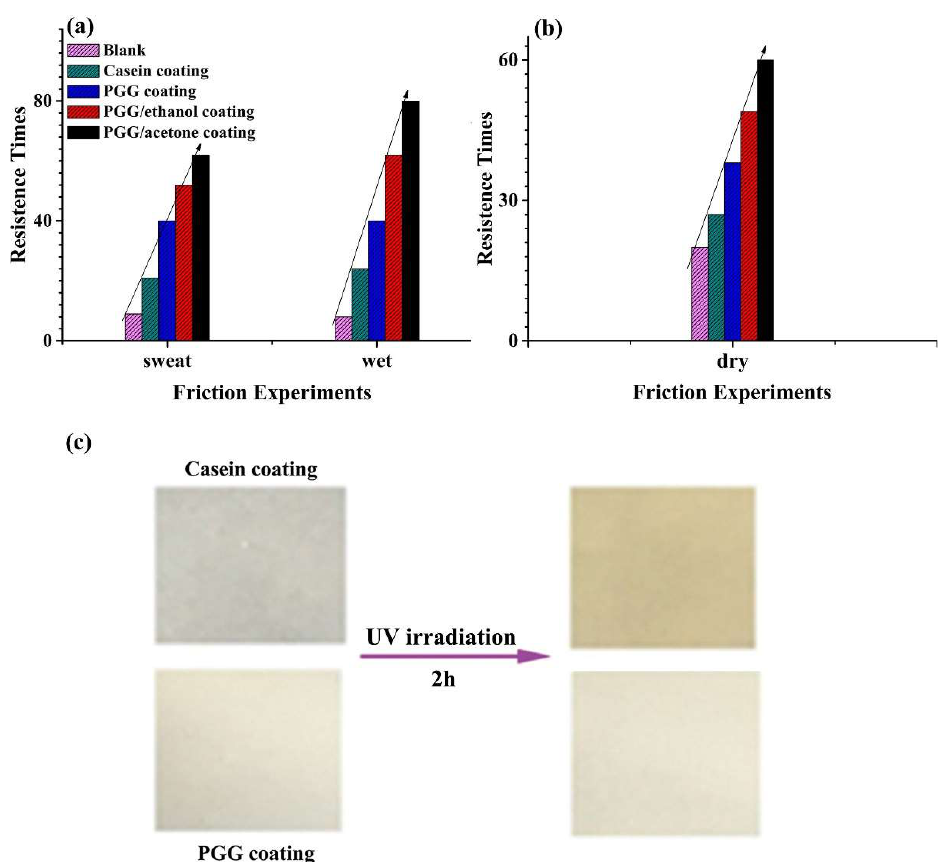
Figure 4. Friction resistance of pure pigskin (blank) and pigskin coated with PGG / acetone, PGG / ethanol, PGG, and casein, respectively, under wet and sweat conditions ( a ); friction experiment under dry conditions ( b ); casein and PGG coatings under UV radiation ( c ).